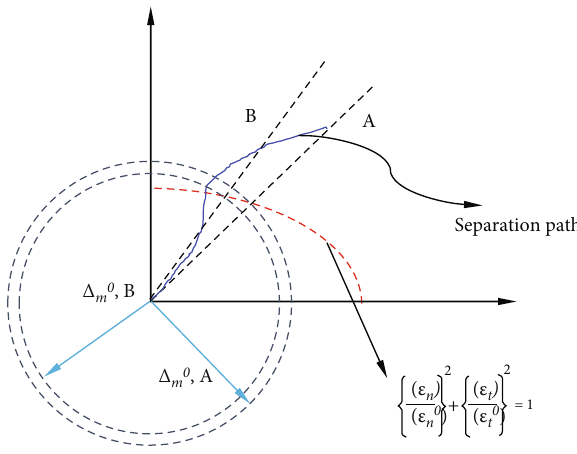
Figure 20: Illustration of mode mix dependence of Δ 0